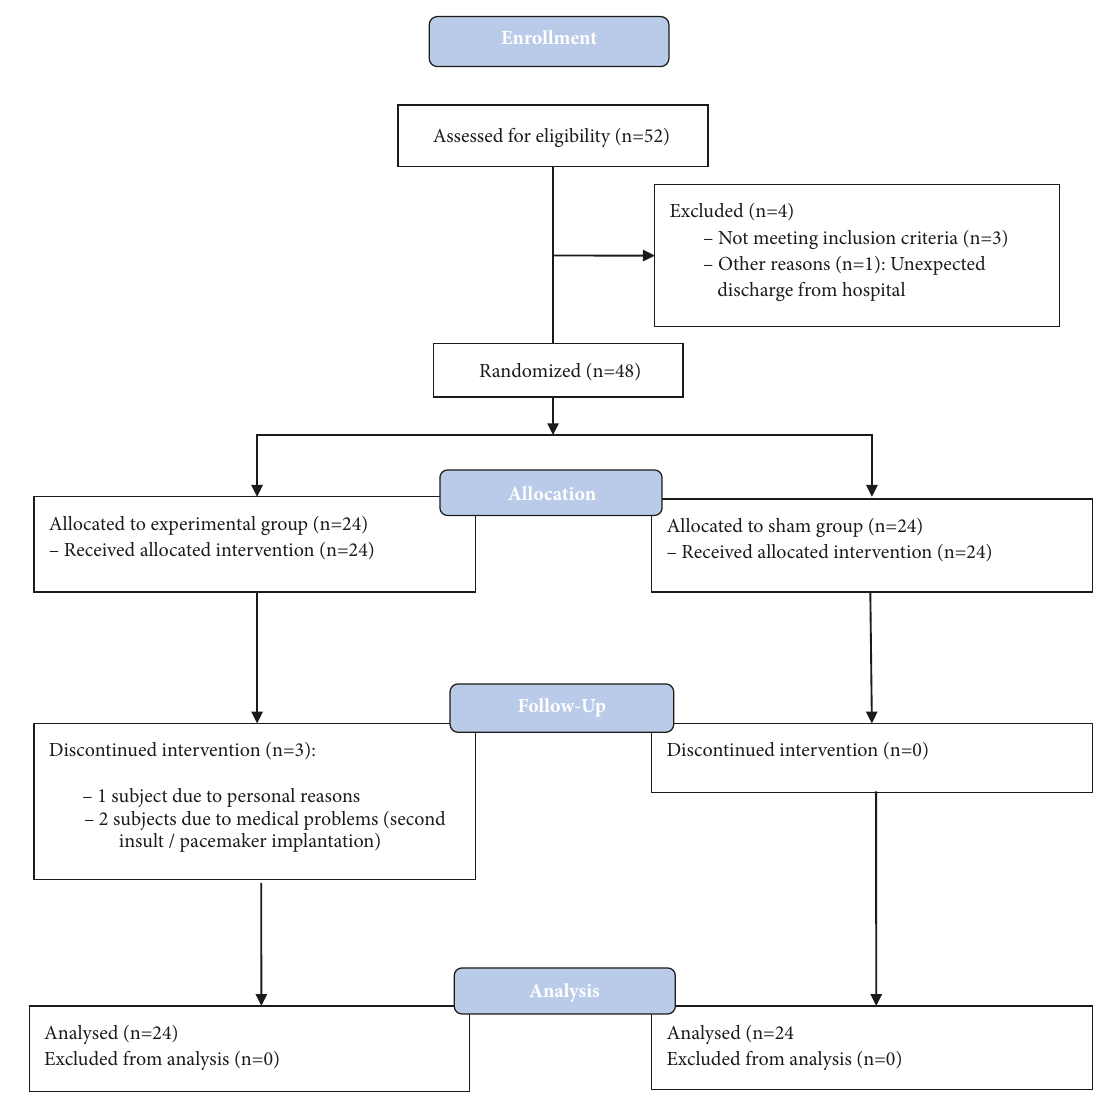
Figure 1: CONSORT diagram of flow of participants through the